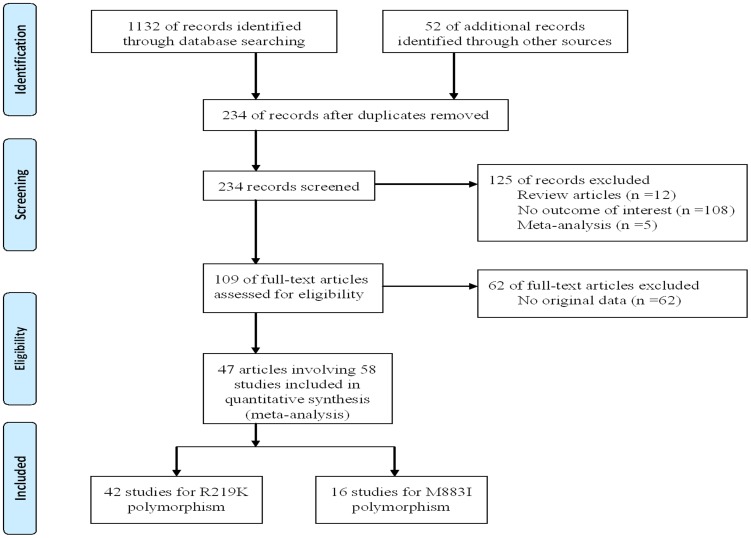
Flow diagram of the study selection process.